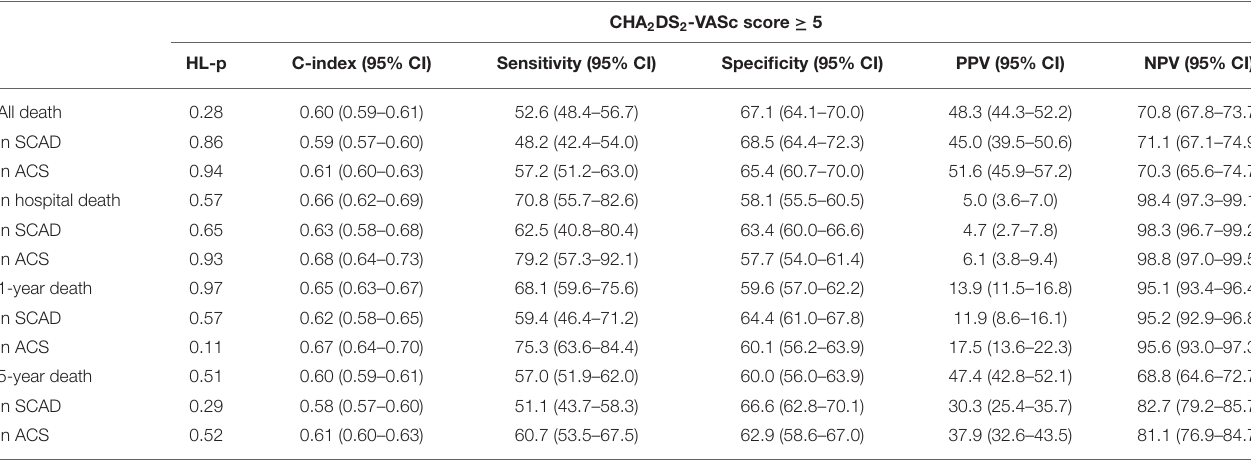
TABLE 3 | Statistics of the CHA 2 DS 2 -VASc Score for the prediction of